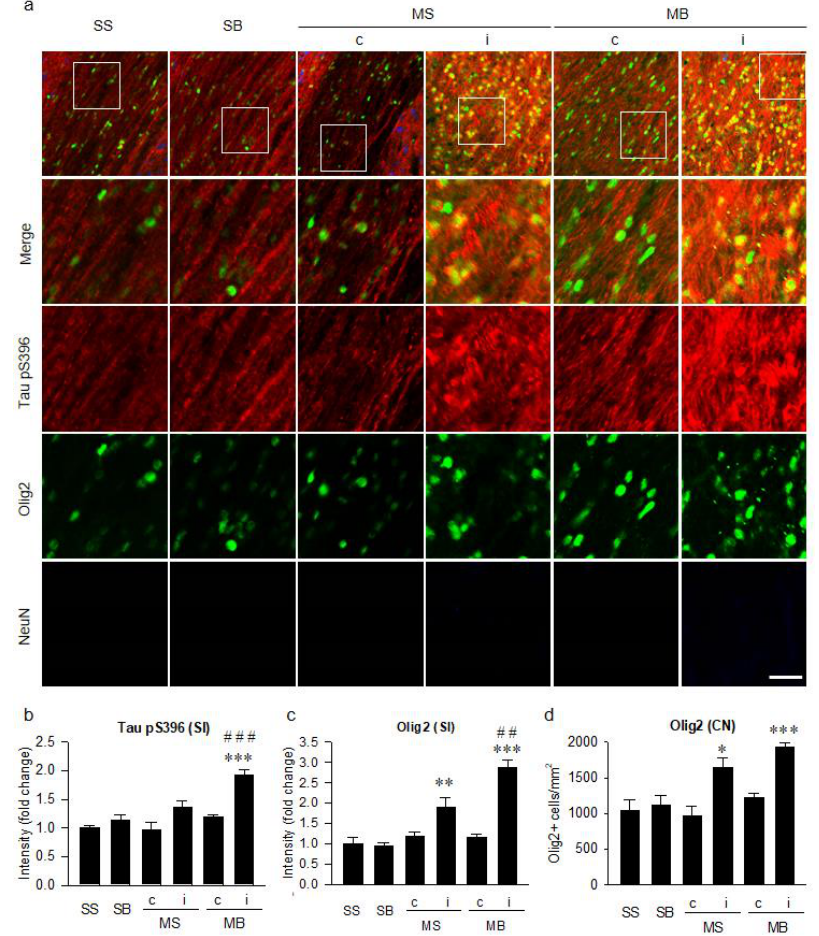
Figure 4. Tauopathy in the corpus callosum. ( a ) Triple-label immunohistochemistry of tau hyperphosphorylation at serine 396 residue (Tau pS396) in conjunction with oligodendrocytes (Olig2) and neurons (NeuN). Quantitative analysis of the signal intensities of Tau pS396 ( b ), the signal intensities of Olig2 ( c ), and the number of Olig2-positive cells ( d ). n = 6 per group; scale bar = 20 μm; SS, sham + sham; SB, sham + BCCAo; MS, MCAO + sham; MB, MCAO + BCCAo; MCAO, middle cerebral artery occlusion; BCCAo, bilateral common carotid artery occlusion; c, contralateral; i, ipsilateral; SI, signal intensity; CN, cell number; * p < 0.05, ** p < 0.01 and *** p < 0.001 compared to SS; ## p < 0.01 and ### p < 0.001 compared to the ipsilateral MS.